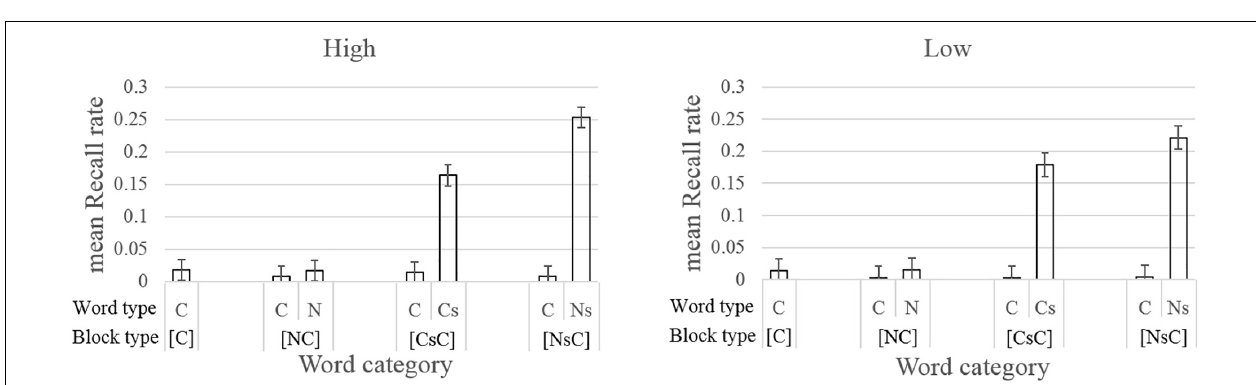
FIGURE 4 | Mean recall rate for high and low trait anxiety group in each Word category. Error bars represent 95% confidence interval adjusted for the within-subject design, calculated separately for high and low trait anxiety group (Masson and Loftus, 2003). C, neutral word; N, negative word; s, word is